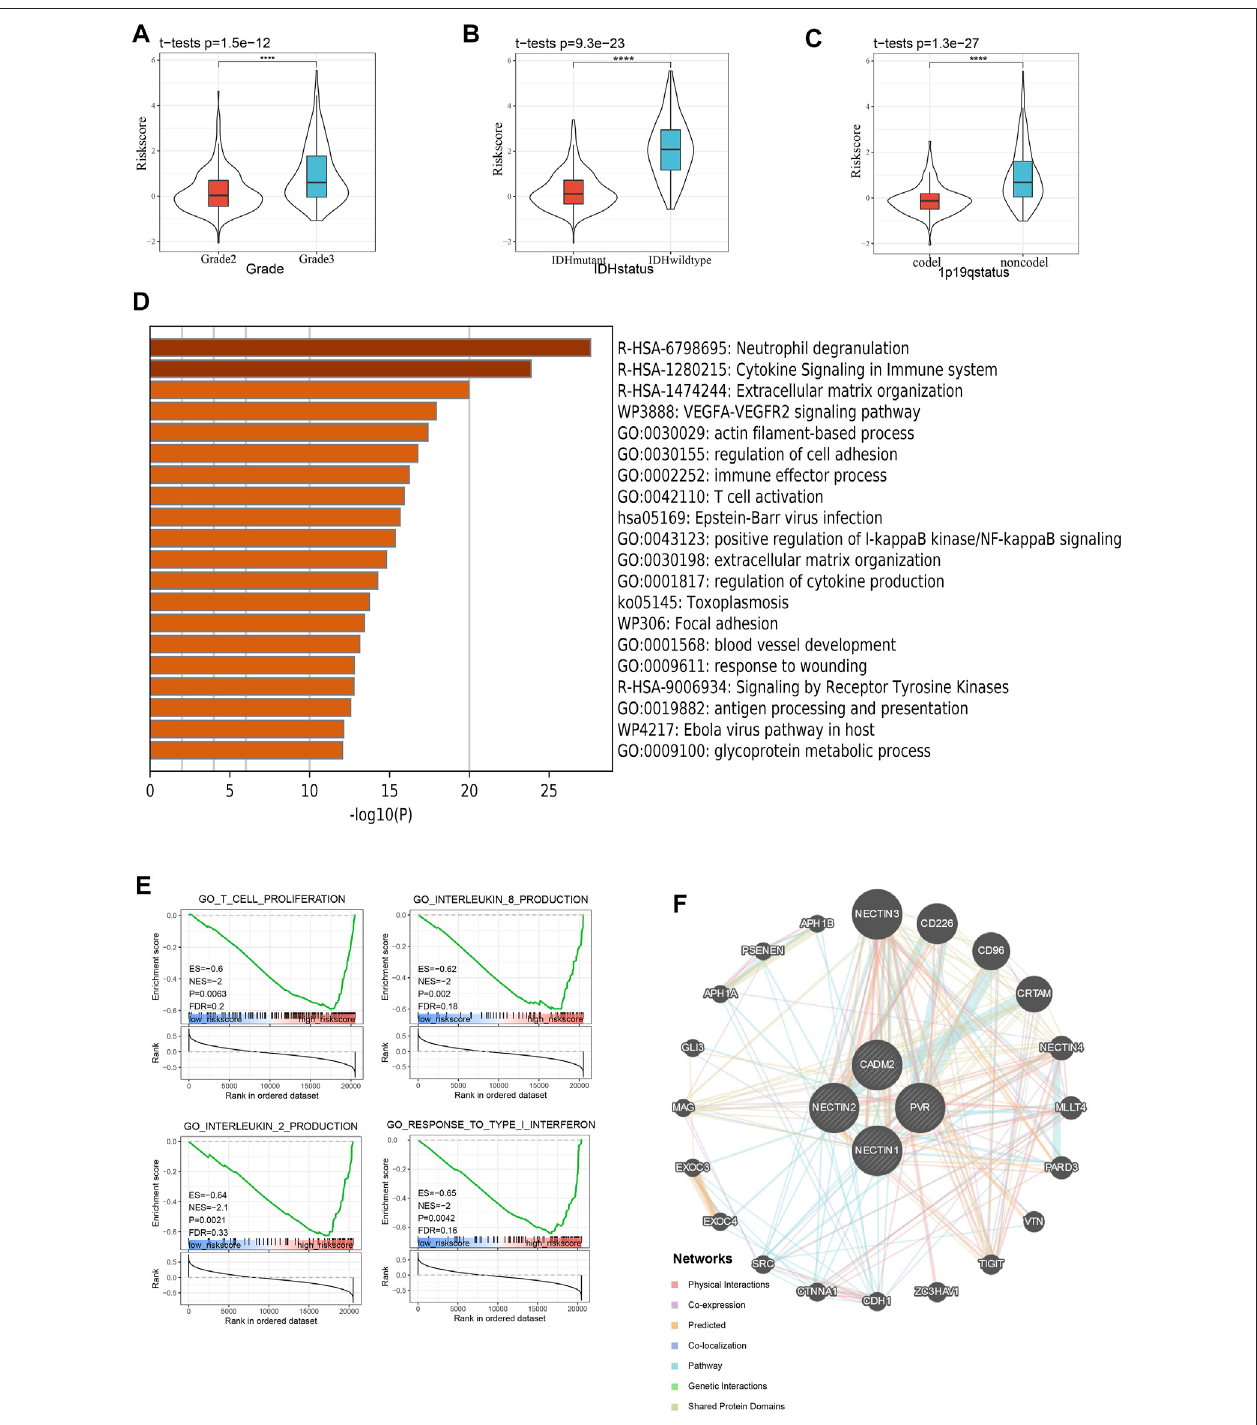
FIGURE 5 | Enrichment and correlation analysis among risk score in TCGA database. (A-C) violin plot indicates the relationship between risk score and grade (A) , IDH status (B) , and 1p19q status (C) in TCGA. D Heatmap of top 20 enriched terms of top 1,000 correlated genes with risk score in TCGA LGG samples, colored by p -value. E GSEA of risk score in the TCGA LGG cohort indicating an association of risk score with immune response. F PPI network of risk score related genes from GENEMANIA.